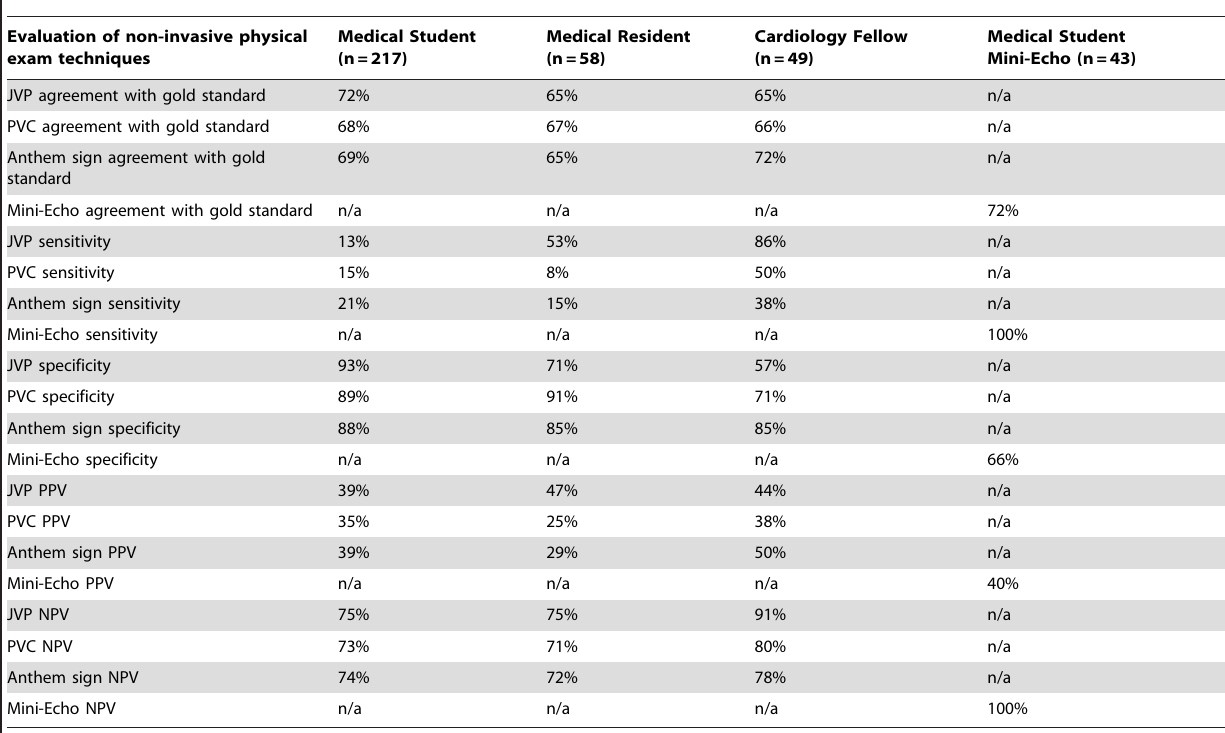
Table 2. Sensitivity and specificity of the physical exam techniques in the general patient population.